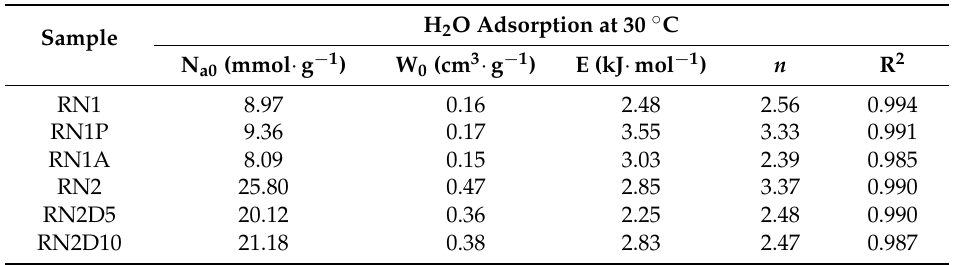
Parameters estimated from the fitting of the H 2 O adsorption isotherms to the Dubinin-Astakhov (DA)